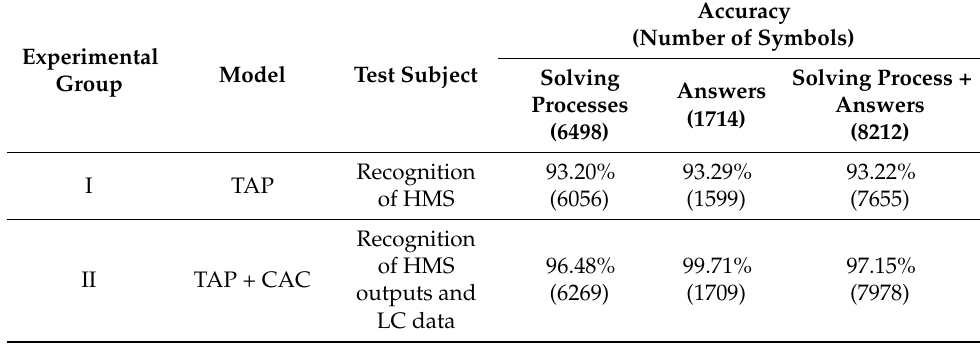
Table 10. Experiment